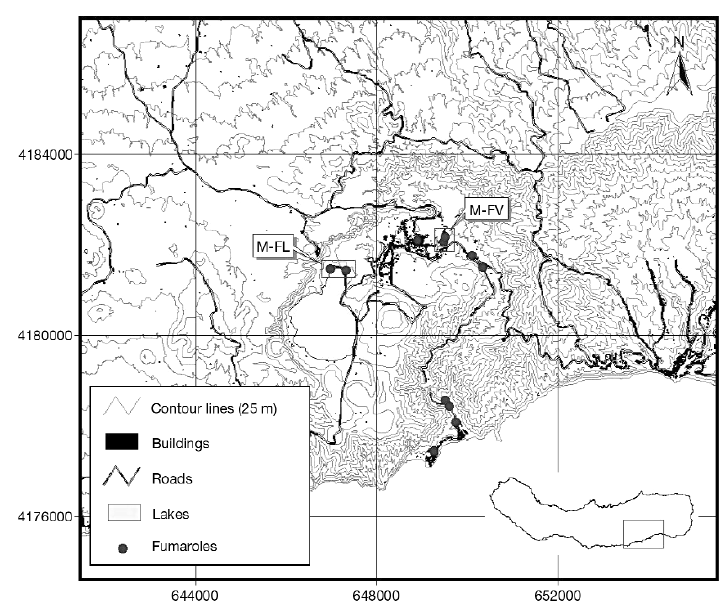
Fig. 2. Furnas volcano, S. Miguel Island, fumarolic fields (M-FL – Furnas Lake; M-FV – Furnas Village).